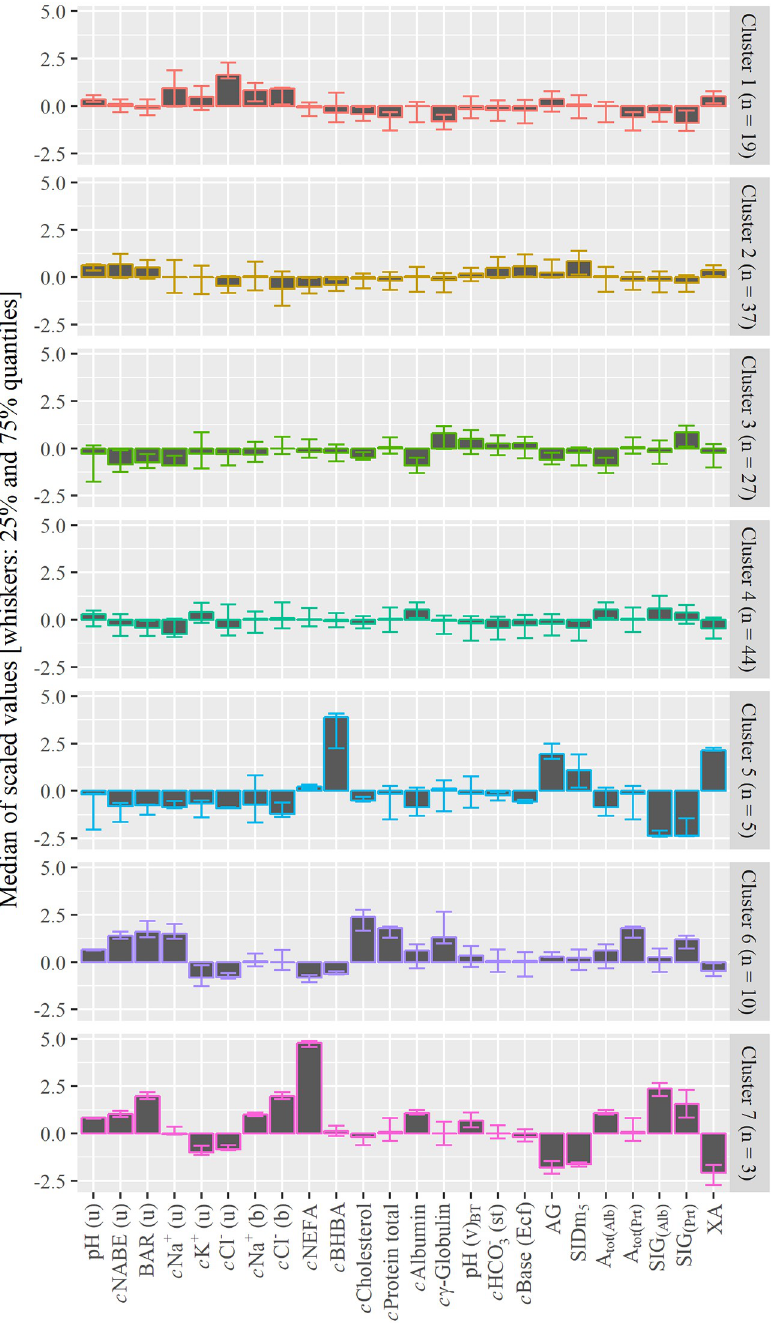
Fig 1. Evaluated parameters of urine and blood and their distribution in the 7 clusters. Centered and scaled medians (filled boxes) with the 50 percent interquartile range (whiskers).